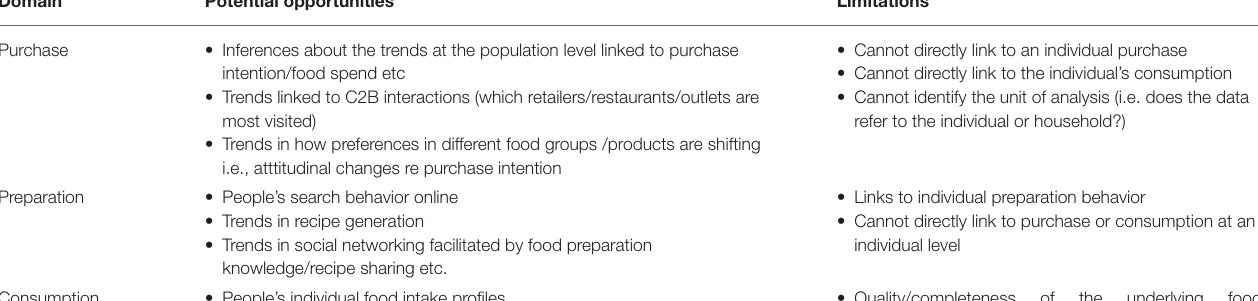
TABLE 3 | Potential opportunities and associated limitations for the scientific use of purchase, preparation, and consumption consumer-generated data.